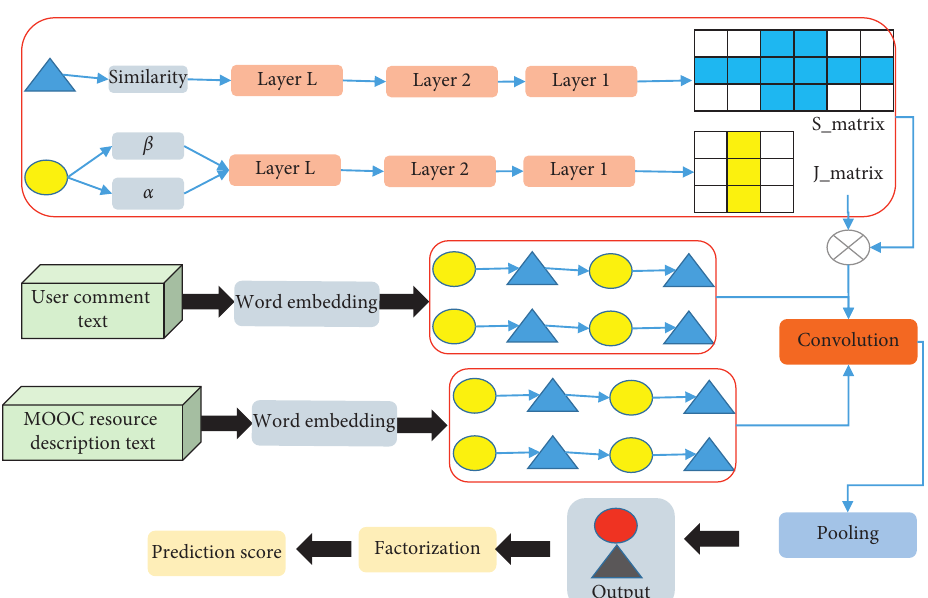
Figure 2: Algorithm framework diagram based on deep